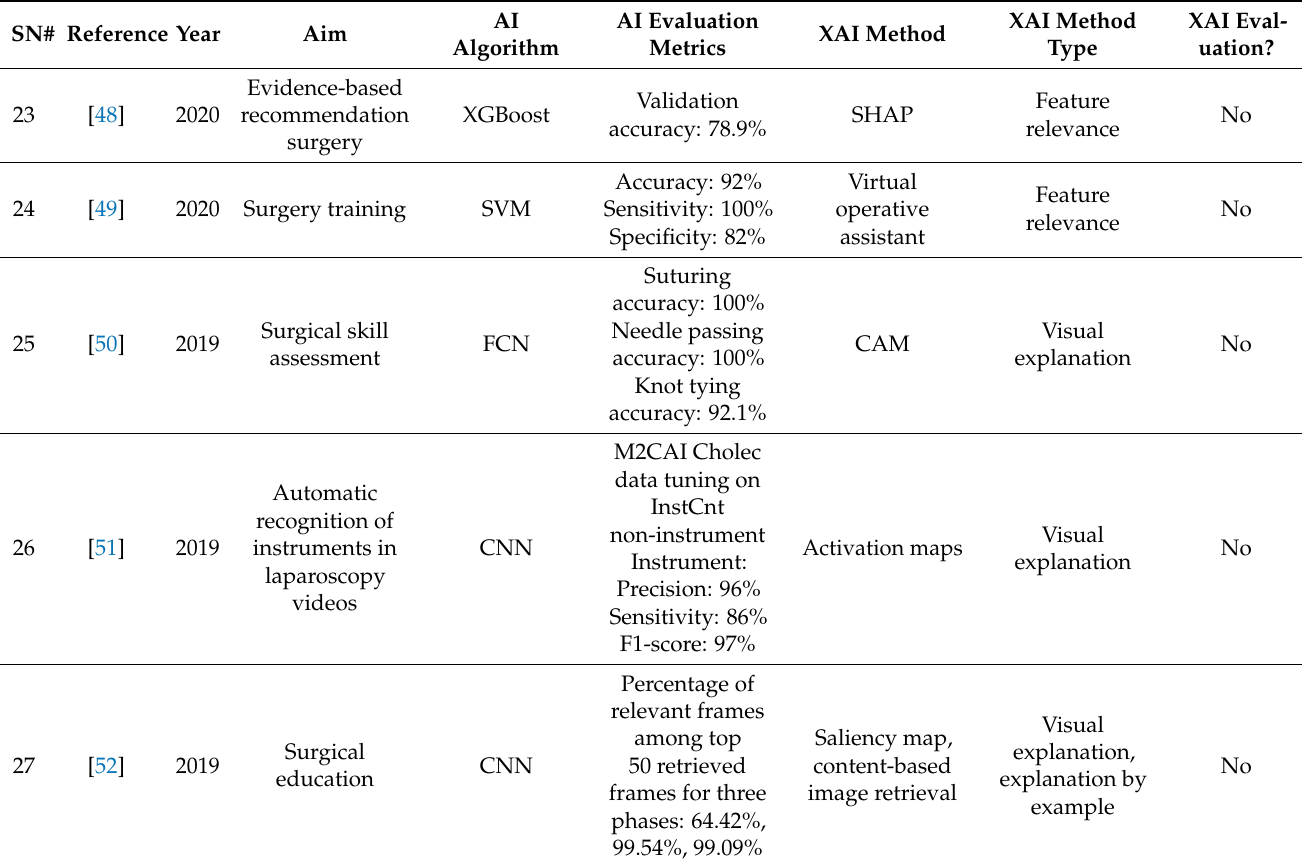
Table 2. Literature review of medical XAI applications in